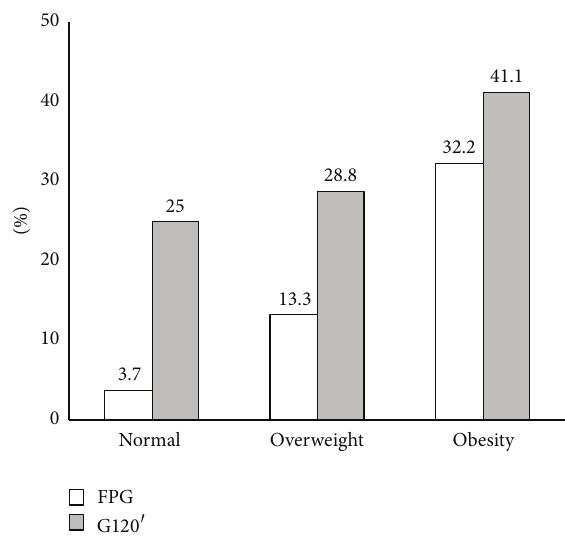
Figure 3: Prevalence of disorders of carbohydrate metabolism in patients with PCOS according to the BMI